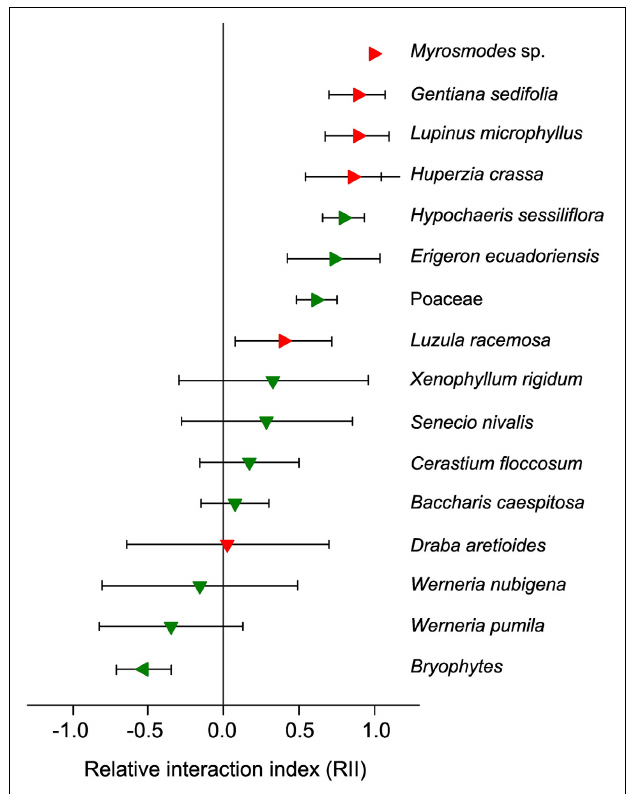
FIGURE 3 | Tropical alpine species observed in the superpáramo of Volcano Antisana and the outcome of their interactions with the cushion plant Azorella aretioides (Ecuador, 4700m a.s.l.). RII > 0: species facilitated by A. aretioides (right-facing triangles); RII < 0: species inhibited by A. aretioides (left-facing triangles); RII not significantly different from 0: neutral interactions (downward-facing triangles; Anthelme et al., 2012). Red triangles indicate that the species were not observed in the adjacent, recently deglaciated site (between 0 and 13 years after glacial recession; Cauvy-Fraunié, 2010). Green triangles indicate that the species were observed in the recently deglaciated site. Error bars represent the 95%